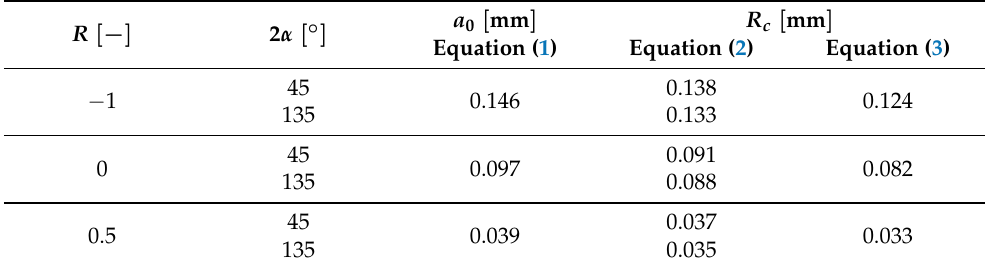
Table 4. Results of the evaluation of R c and a 0